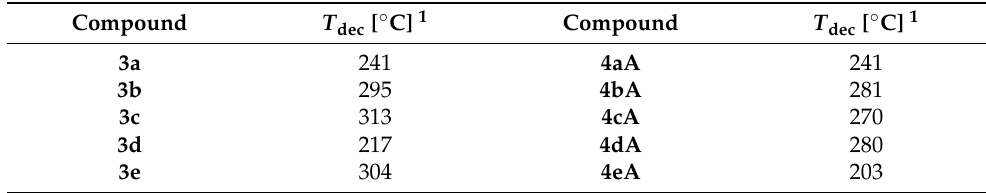
Figure 4. TGA thermograms of the fluorinated derivatives under a nitrogen atmosphere (scan rate = 10 ◦ C · min –1 ): ( a ) merophosphinines 3a – 3e ; ( b ) phosphinines 4aA – 4eA . Table 2. Thermal decomposition temperatures ( T dec ) of the fluorinated merophosphinine ( 3a – 3e) and phosphinine ( 4aA – 4eA ) derivatives.